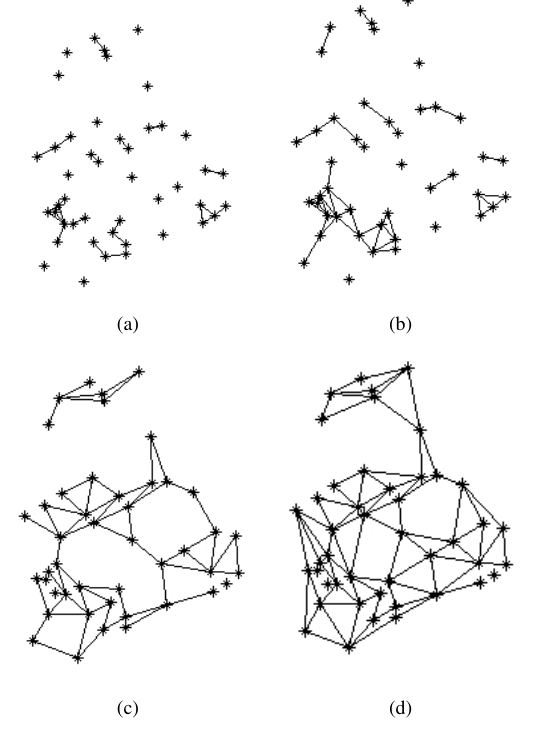
Figure 4: Planar graphs of industrial area: (a) distance range 0- 30 m; (b) 10-40 m; (c) 30-60 m; and (d) 30-80 m.